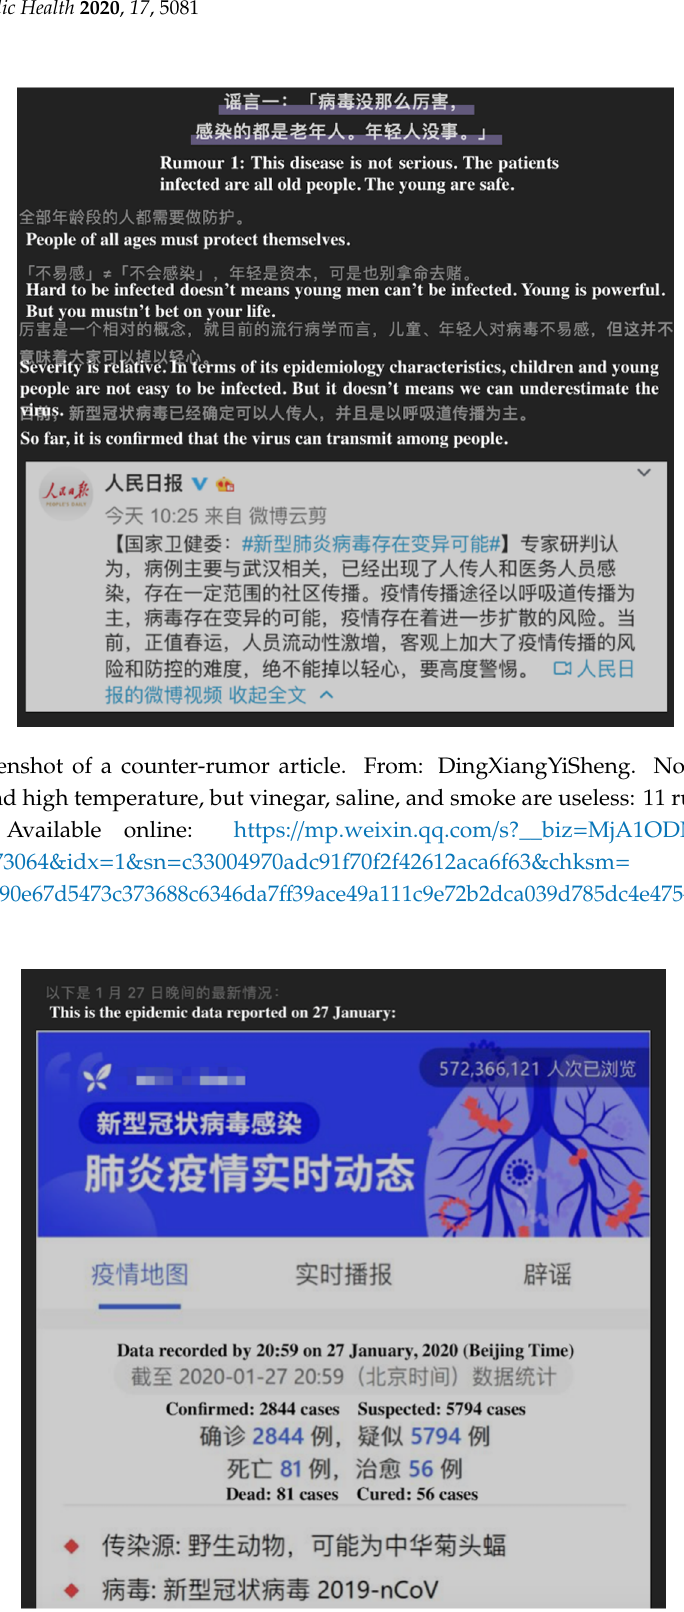
Figure 5. Screenshot of a report article. From: DingXiangYiSheng. COVID-19 Situation Report on 27 Jan,